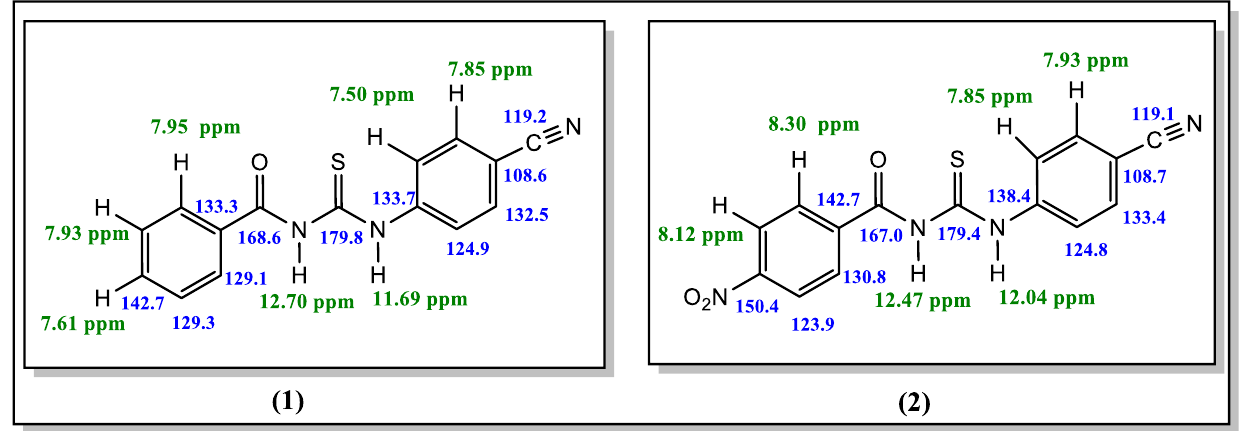
Figure 1. 1 H and 13 C-NMR chemical shift of the title compounds 1 and 2 in DMSO- d6 .